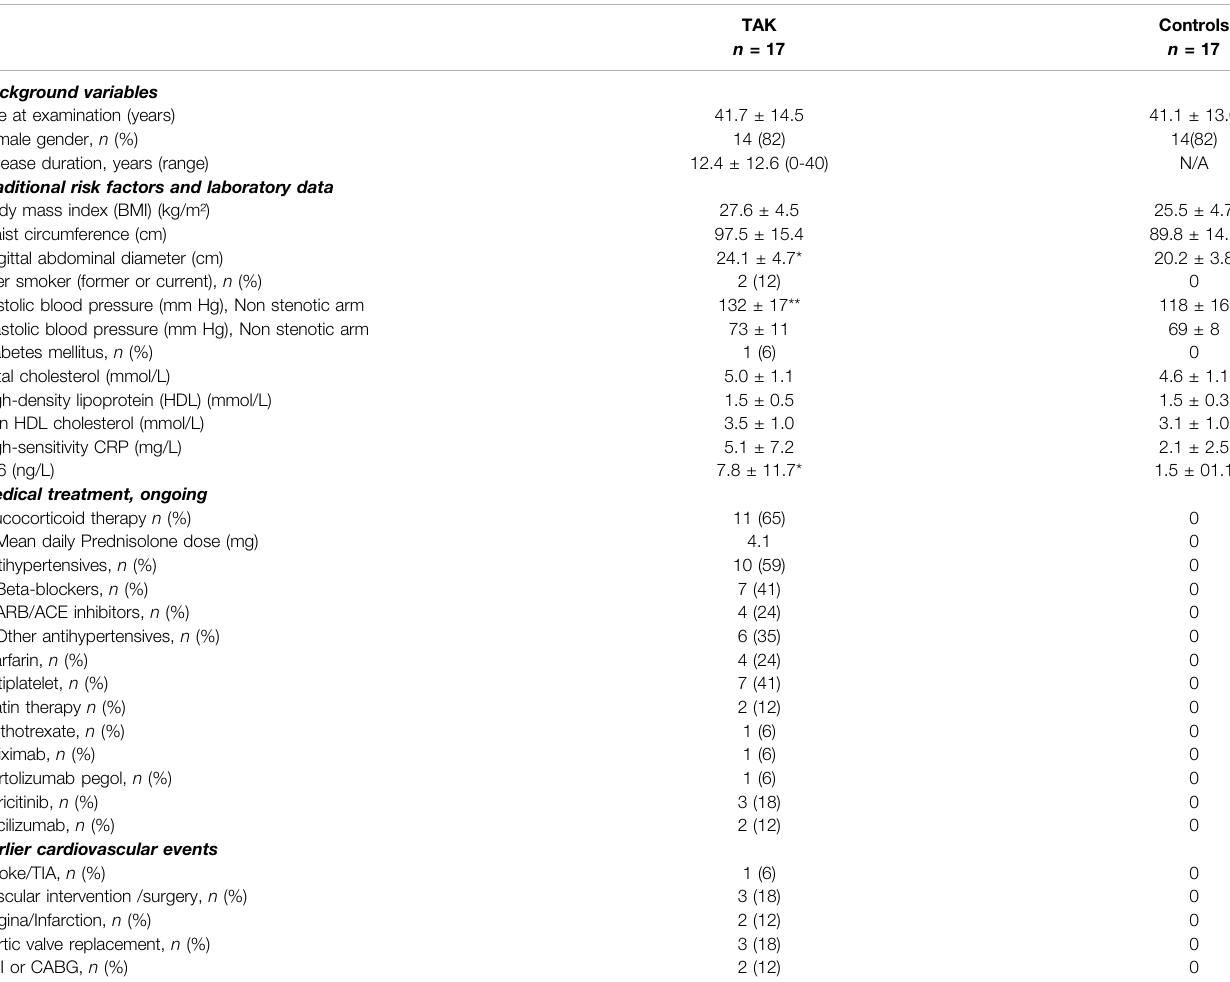
TABLE 1 | Detailed characteristics of included patients and controls presented as mean ± SD or n